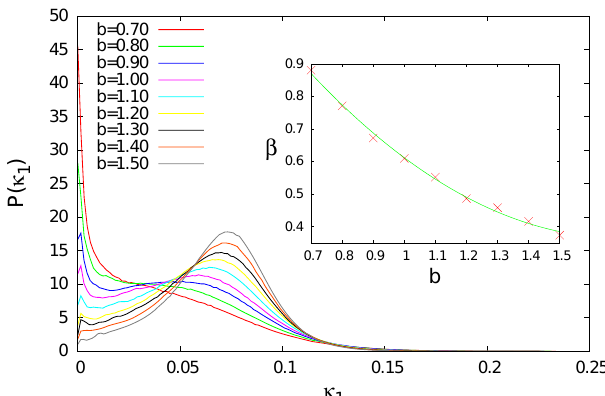
Fig. 2. (color online) The probability density function P(κ 1 ) versus κ 1 for several values of b for temporally uncorrelated events obey- ing Eq. (4). The inset depicts the variability β as a function of b (the cross symbols refer to directly computed values, while the curve has been drawn as a guide to the